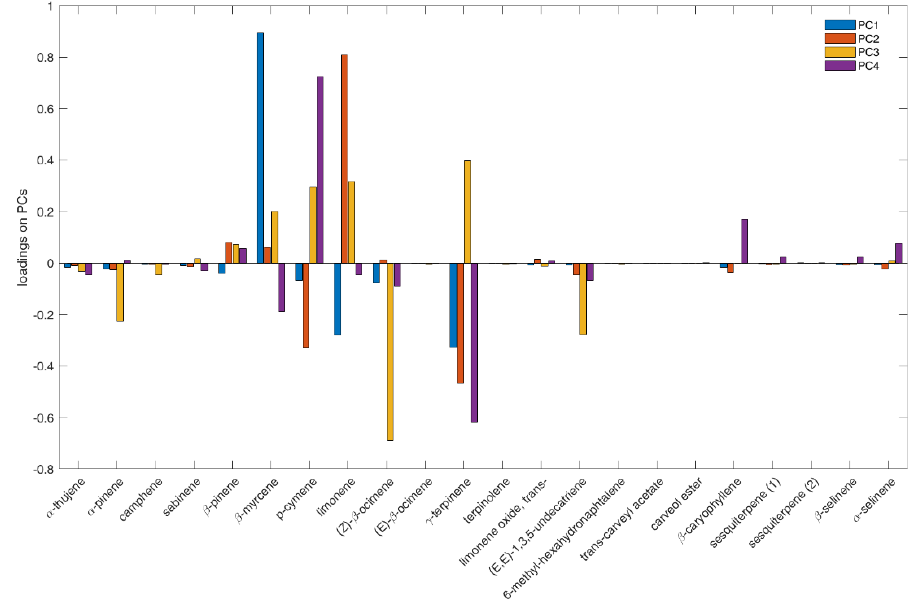
Figure 2. Variable loadings on the first four PCs extracted from the centered percentage peak areas provided by celery petiole volatiles.